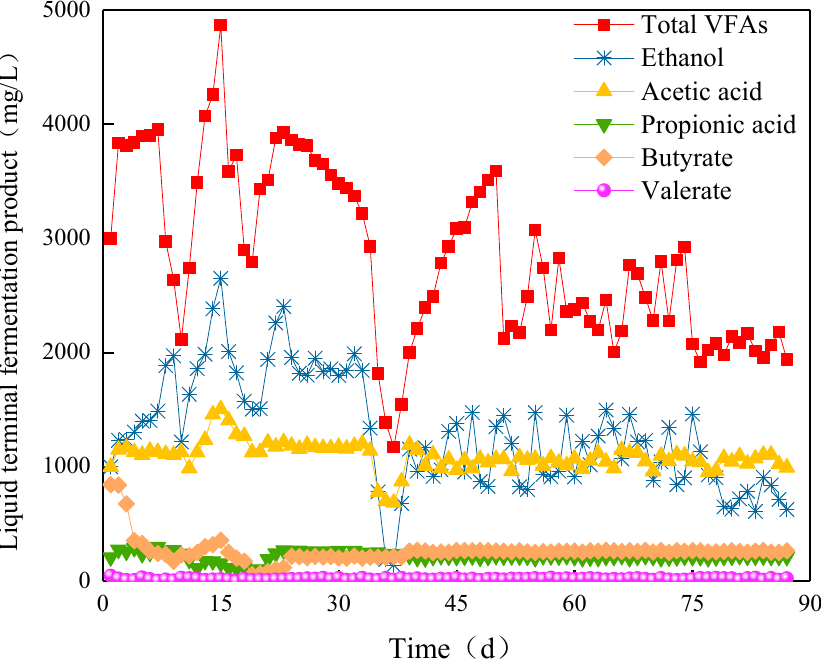
Figure 9. Ethanol and VFAs yields in Compartment II.